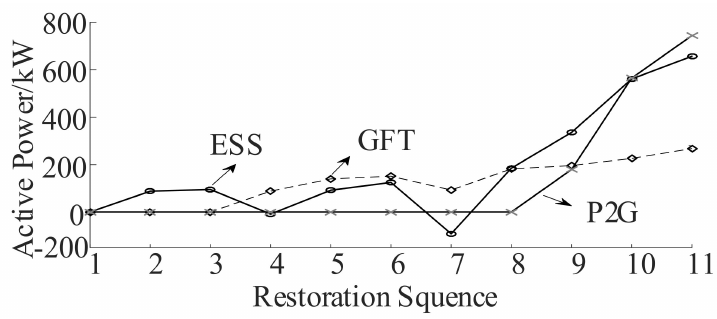
Figure 14. Output curve of energy conversion